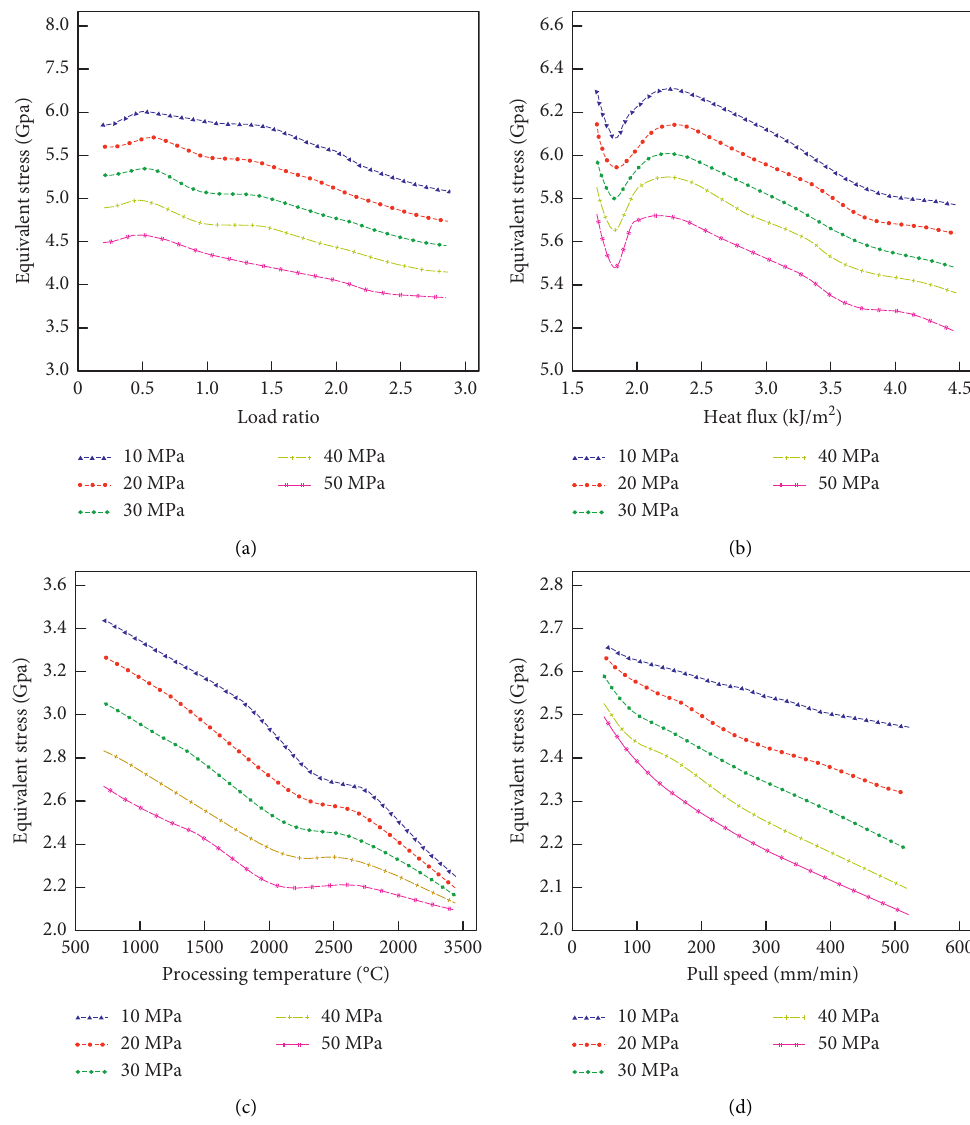
Figure 5: Relationship between equivalent stress and load ratio. (a) Heat flux. (b) Processing temperature. (c) Pull speed. (d) Different processing